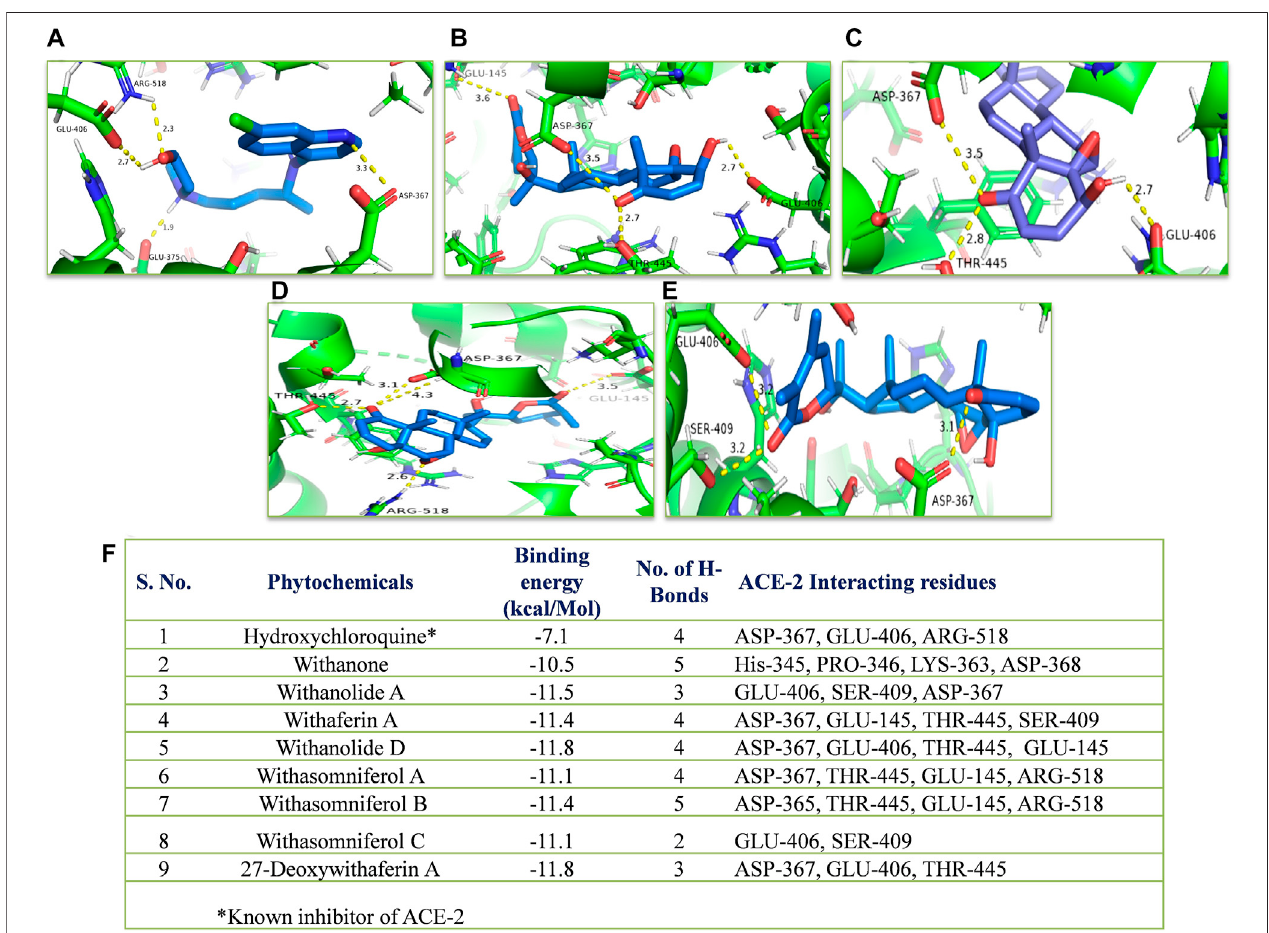
FIGURE 8 | Molecular docking of the proposed withanolides with ACE-2. Docked conformations of withanolides and standard drug [ (A) hydroxychloroquine, (B) withanolide D, (C) 27 deoxy withaferin, (D) withasomniferol B, (E) withanolide A] within the ACE-2 drug-binding cavity. (F) molecular docking results table. The protein interacting residues are labeled (in black) with the H-bond interactions (represented by yellow dashed